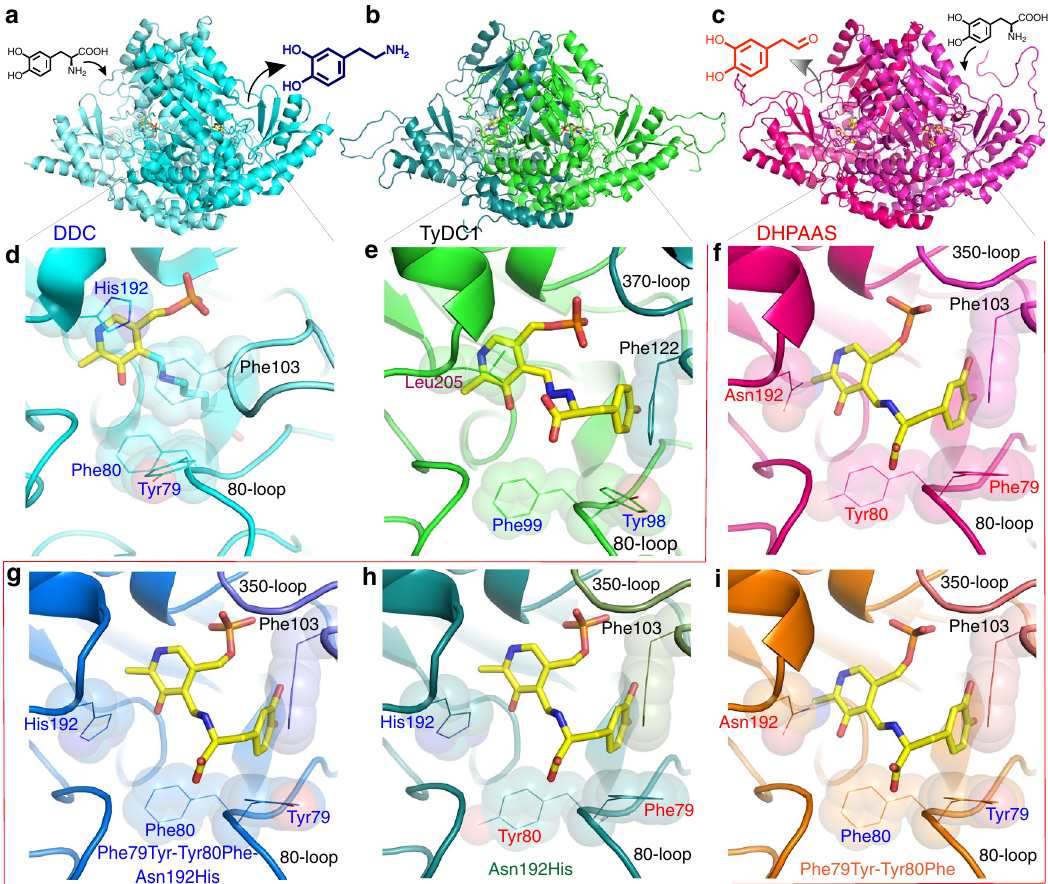
Fig. 3 Structural analysis of AAAD and DHPAAS. Comparison of Drosophila melanogaster DDC in complex with PLP (cyan, a and d , PDB ID: 3K40) 25 , P. somniferum TyDC1 in complex with PLP-tyrosine (green, b and e ), and wild-type B. mori DHPAAS in complex with PLP-DOPA (magenta, c and f ). Phe79 and Tyr80 are conserved in DHPAAS sequences, whereas this motif is reversed to Tyr79 and Phe80 in typical AAAD, which includes DDC. In the D. melanogaster DDC-PLP complex with no substrate, Phe103 extends inwards towards the PLP cofactor. The bottom three panels show engineered active sites of Phe79Tyr-Tyr80Phe-Asn192His ( g , blue), Asn192His ( h , dark green) and Phe79Tyr-Tyr80Phe ( i , orange) variants of B. mori DHPAAS, all in complex with